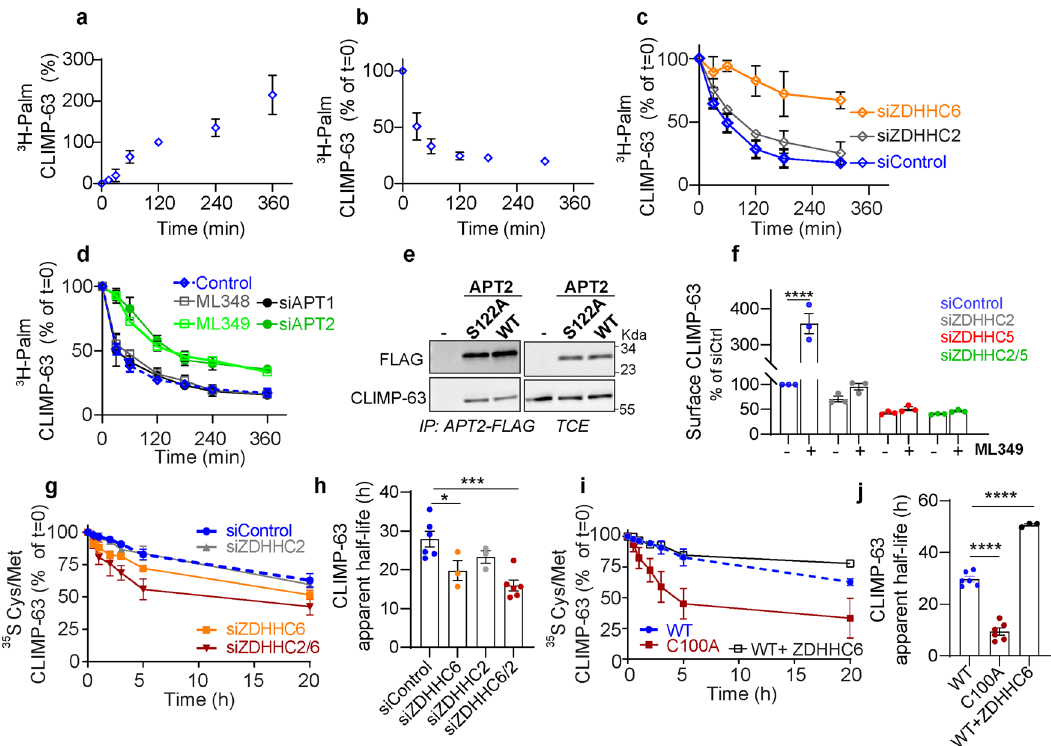
Fig. 3 | Cycles ofDe/Palmitoylation ofCLIMP-63 by APT2 and ZDHHC6 control its turnover and localisation. a Quanti fi cation of 3 H-palmitate incorporation into CLIMP-63. Values were normalized to the population at 2h as 100%. Results are mean±SD, n =3. b Quanti fi cation of 3 H-palmitate decay from CLIMP-63 after a 2h pulse of 3 H-palmitate labelling followed by the indicated periods of chase time. Values were normalized to the initial population (t0) as 100% (results are mean± SD, n =5). c , d Quanti fi cation of 3 H-palmitate turnover from CLIMP-63 as in b : c HeLa transfected with control (Ctrl), siZDHHC2 or siZDHHC6 or d HeLa trans- fected with siAPT1 or siAPT2, or treated with speci fi c APT inhibitors ML348 or ML349. Results are mean±SD, n =3. e Co-immunoprecipitation of endogenous CLIMP-63 with overexpressed APT2-FLAG WT or S122A in Rpe-1 cells. f Quanti fi cationofCLIMP-63populationatthecellsurfaceinHeLacellstransfected withcontrol,siZDHHC2,siZDHHC5orsiZDHHC2/5mock-treated(-)ortreatedwith